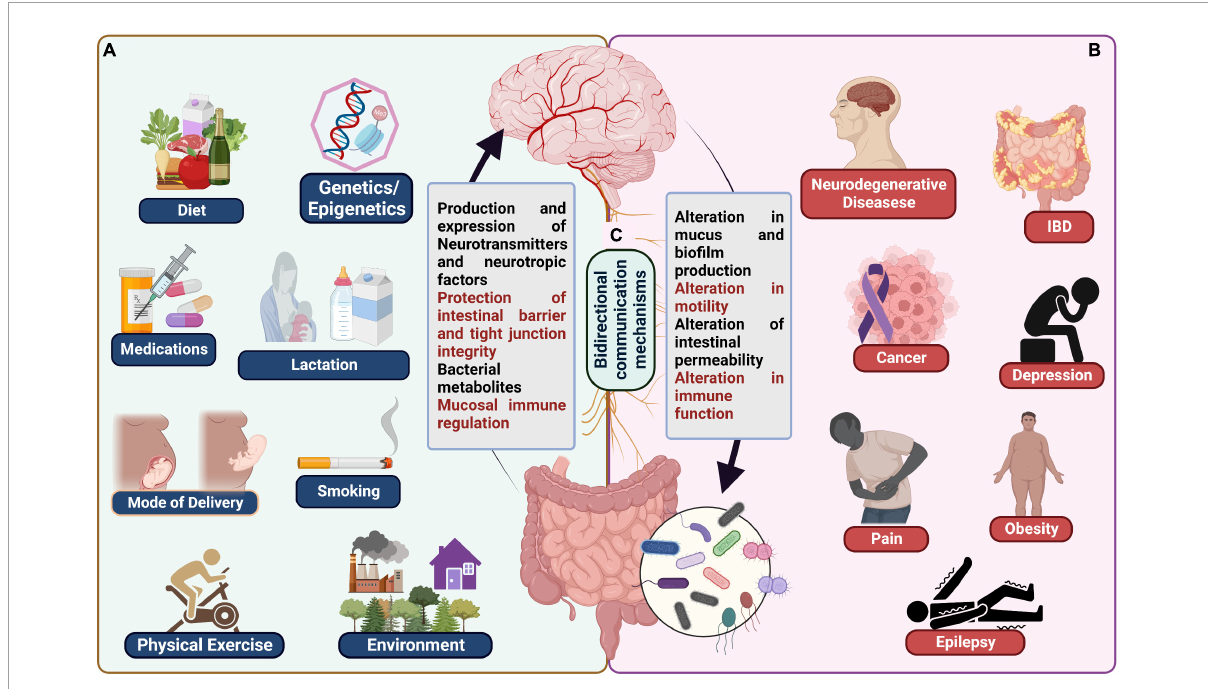
FIGURE1 (A) Examples of typical influences on the microbiota gut-brain axis including genetics/epigenetics, medications, mode of delivery, lactation, smoking, physical exercise, and environment. (B) Various diseases known to be affected by gut brain axis dysbiosis, including neurodegenerative diseases, cancer, IBD, depression, obesity, pain, and epilepsy. (C) Bidirectional communication mechanisms between the gut and the